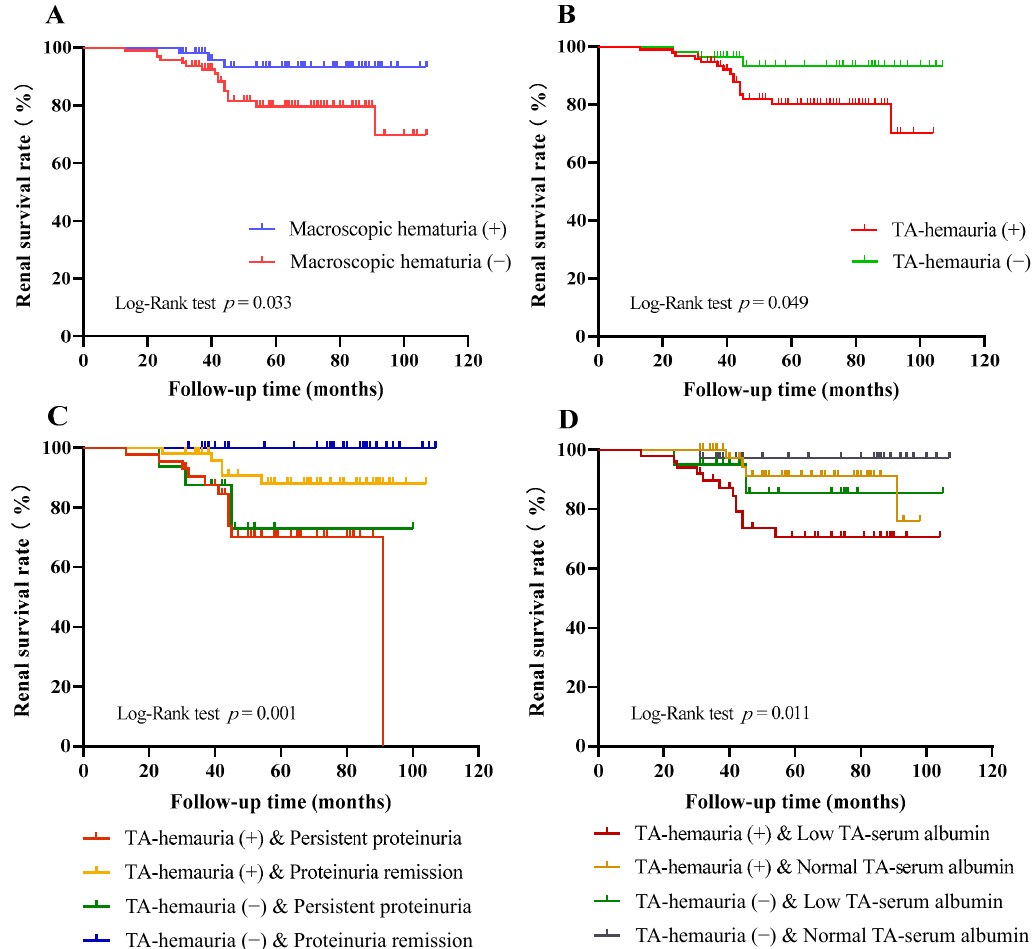
Figure 3. The renal survival rate of the Kaplan-Meier analysis. Kaplan-Meier curves comparison when dividing participants into strata. ( A ) History of macroscopic hematuria (macroscopic hematuria vs. no macroscopic hematuria) ( p = 0.033). ( B ) Levels of time-averaged hematuria (higher TA-hematuria level vs. lower TA-hematuria level) ( p = 0.049). ( C ) Composite TA-hematuria level and proteinuria remission (higher/lower TA-hematuria levels and positive/negative proteinuria remission) ( p = 0.001). ( D ) Composite levels of TA-hematuria and TA-serum albumin (higher/lower TA-hematuria levels and higher/lower TA-serum albumin levels) ( p = 0.011).